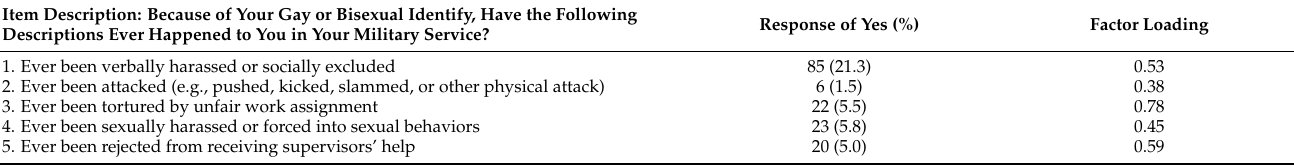
Table A1. Exploratory factor analysis results of the Enacted Sexual Stigma Experiences Scale in Military Service